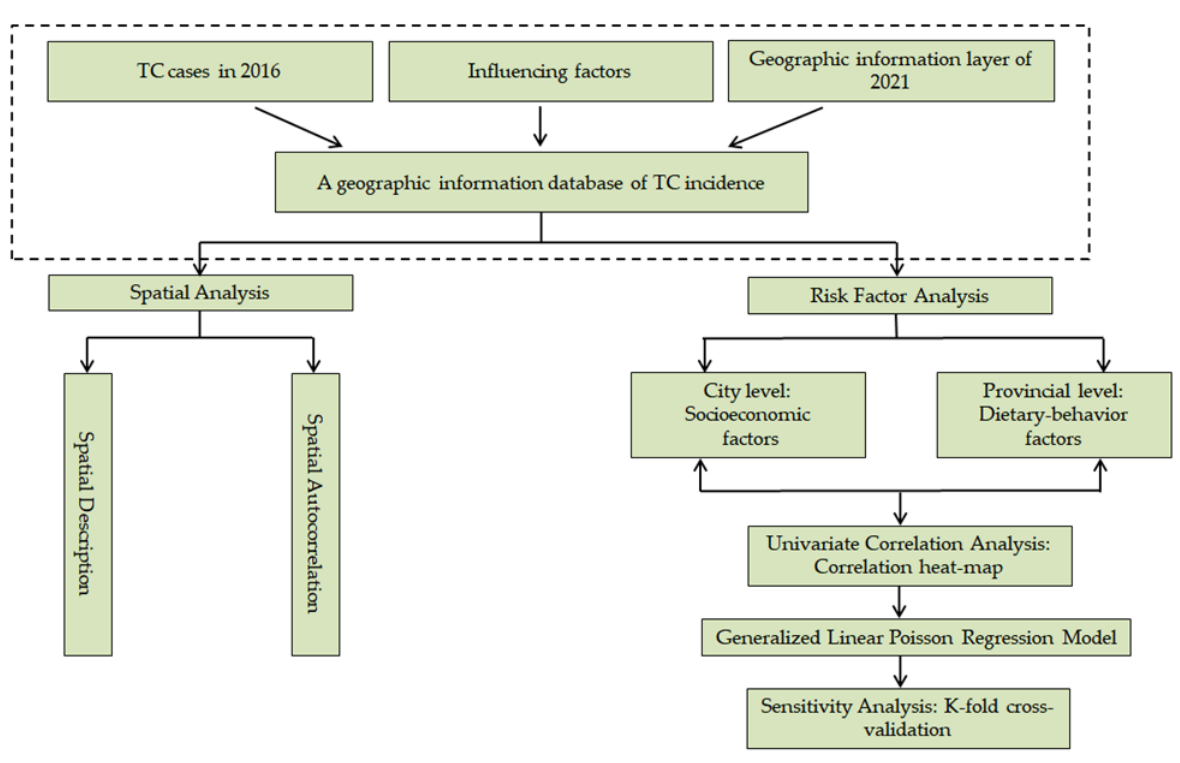
Figure 1. Technology roadmap for this study.